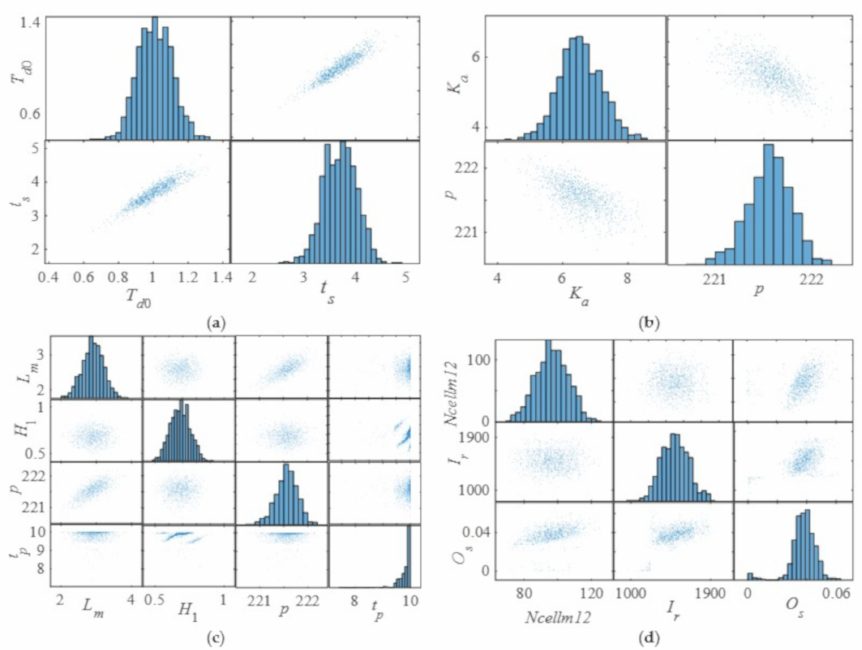
Figure 10. The influence of the wind − solar − hydro system parameters on the DPIs of the generator terminal voltage of PSPP. ( a ) The influence of Td0 on the settling time. ( b ) The influence of Ka on the peak value. ( c ) The influence of Lm and H 1 on the peak value and peak time. ( d ) The influence of Ncellm12 and Ir on the